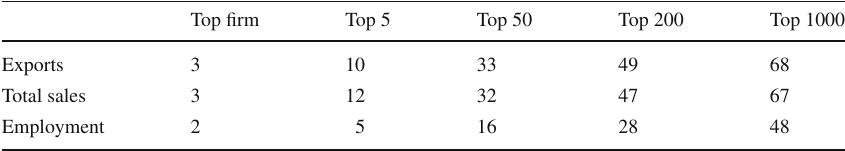
Table 2 Concentration in exports vs. output and employment, 2013 (% of total). Source: Authors’ own calculations, based on the SABI and Customs databases. To make the databases comparable, we have selected exporters operating in the goods sectors (agriculture, industry and retail) from SABI